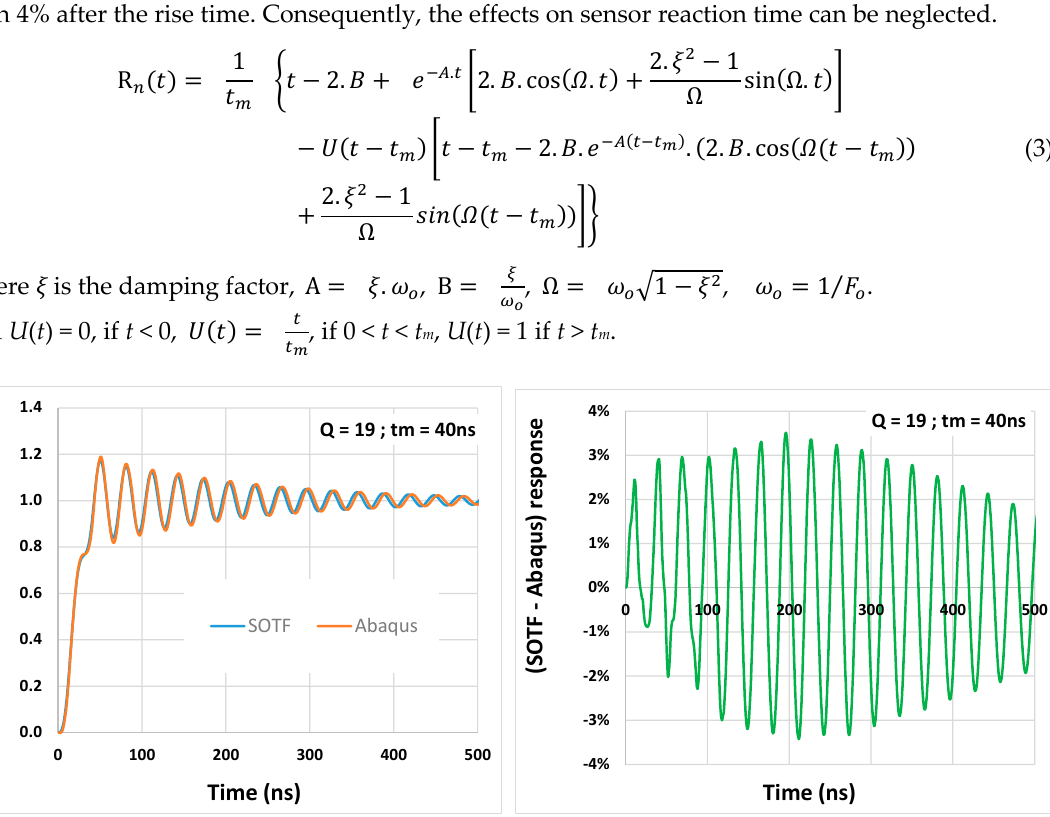
Figure 3. Comparison of SOTF model and Abaqus simulation results for the dynamic